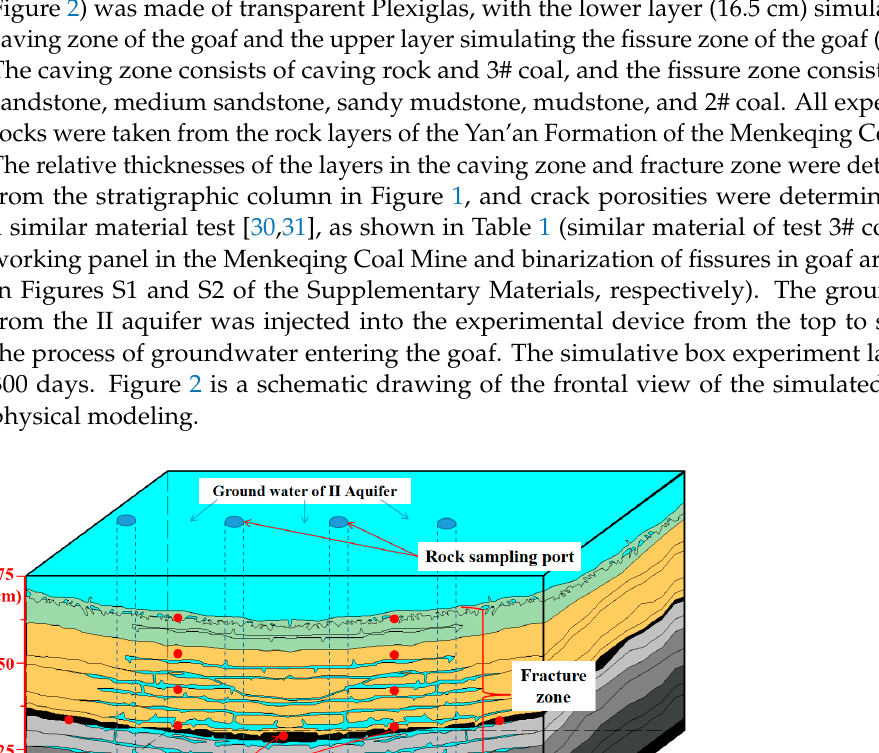
Table 1. Parameters of rock layers in the physical modeling.